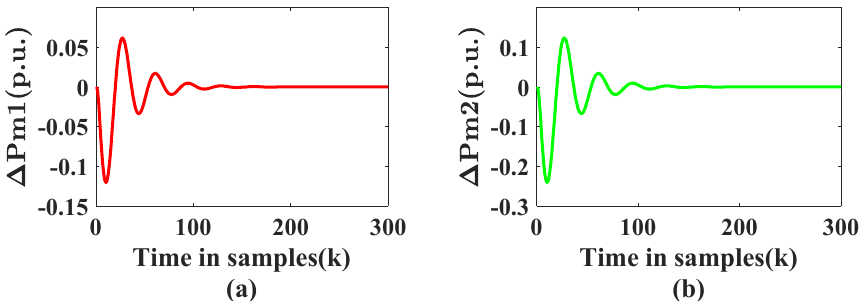
Figure 9. Output deviation signal of turbine body ∆ P m under the PSO-MPC strategy with wind turbines. ( a ) Output deviation signal of turbine body Δ P m under Δ P L 1 ; ( b ) Output deviation signal of turbine body Δ P m under Δ P L 2 .